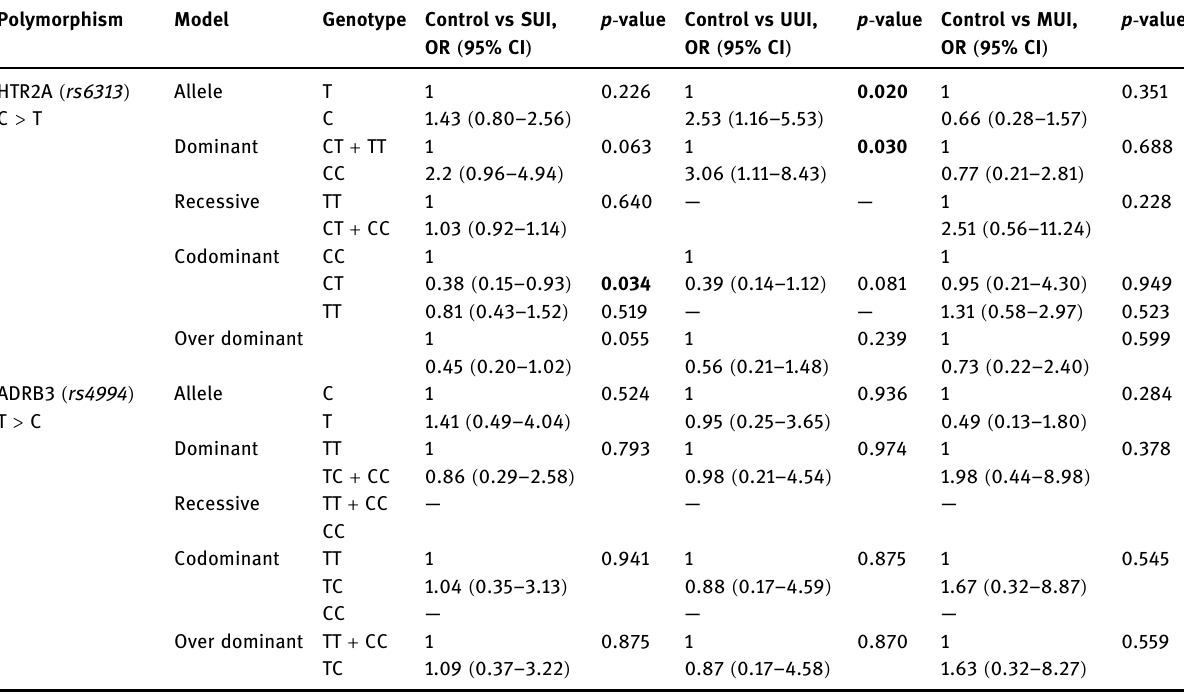
Table 3: ADRB3 Trp 64 Arg and HTR2A T102C polymorphisms in fl uence in di ff erent UI types